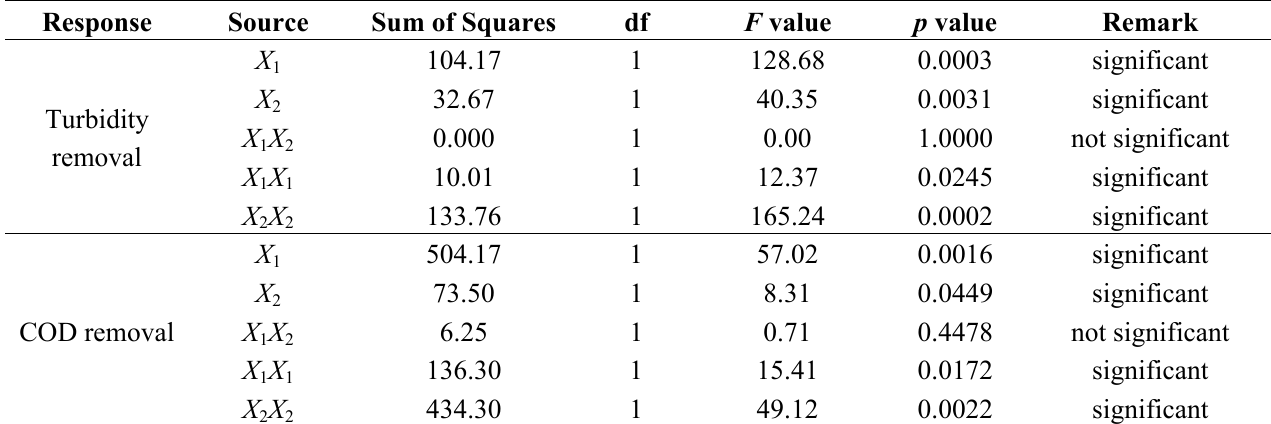
Table 3. Analysis of variance (ANOVA) results showing the terms in each response quadratic